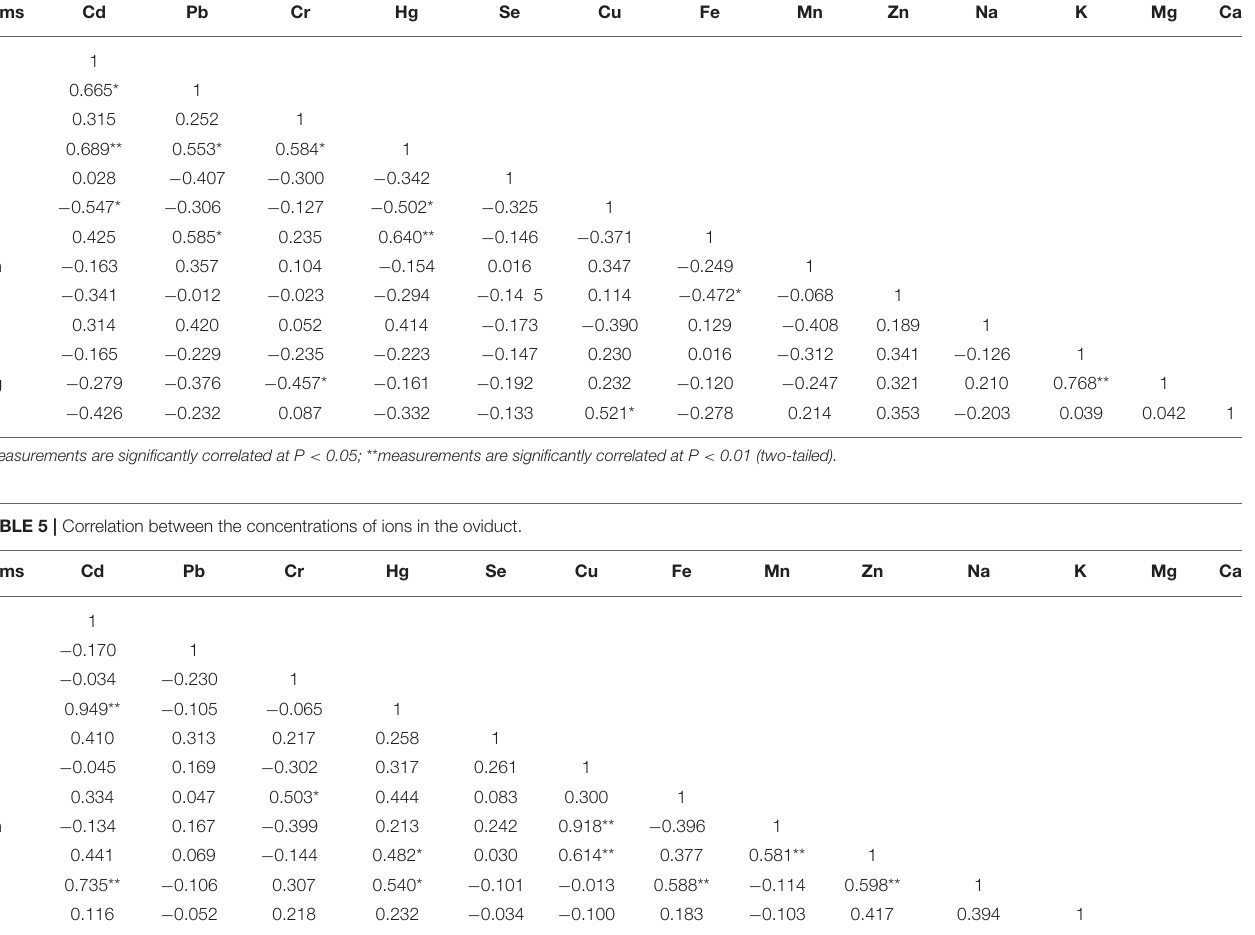
TABLE 4 | Correlation between the concentrations of ions in the ovary. Items